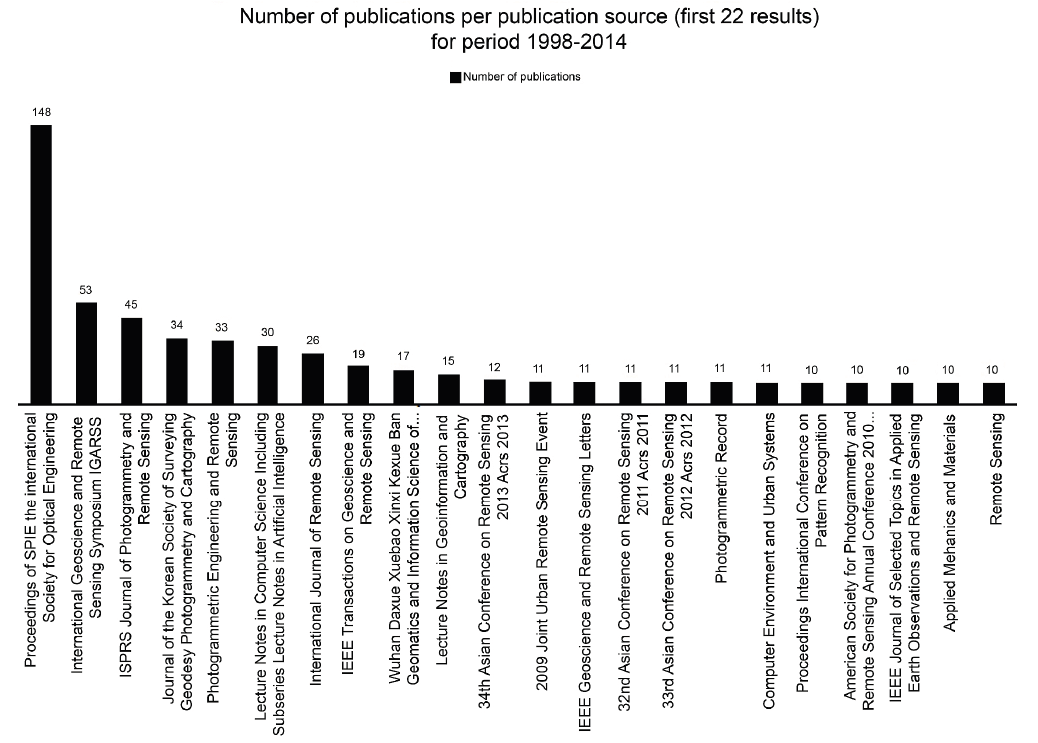
Figure 2. Number of publications per publishing source for period from 1998 to 2014 (first 22 results). Source: Scopus, July 2014.